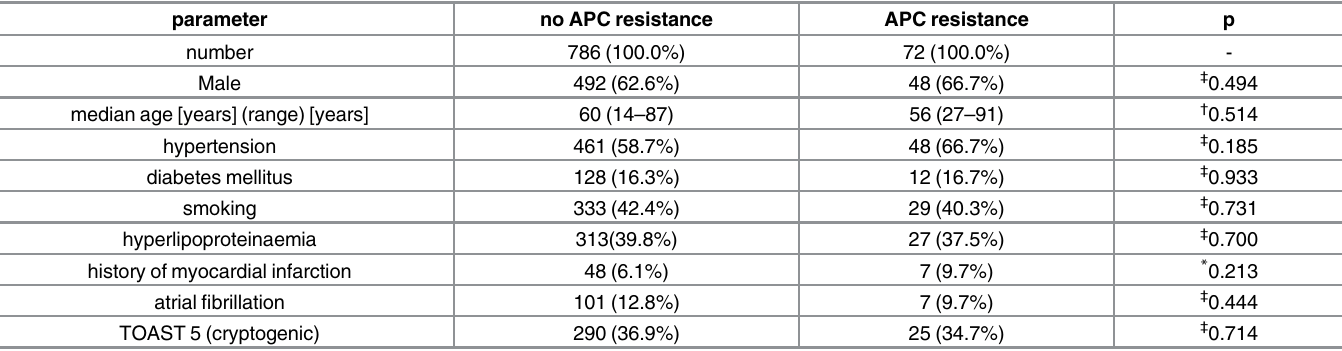
Table 2. Baseline data of included